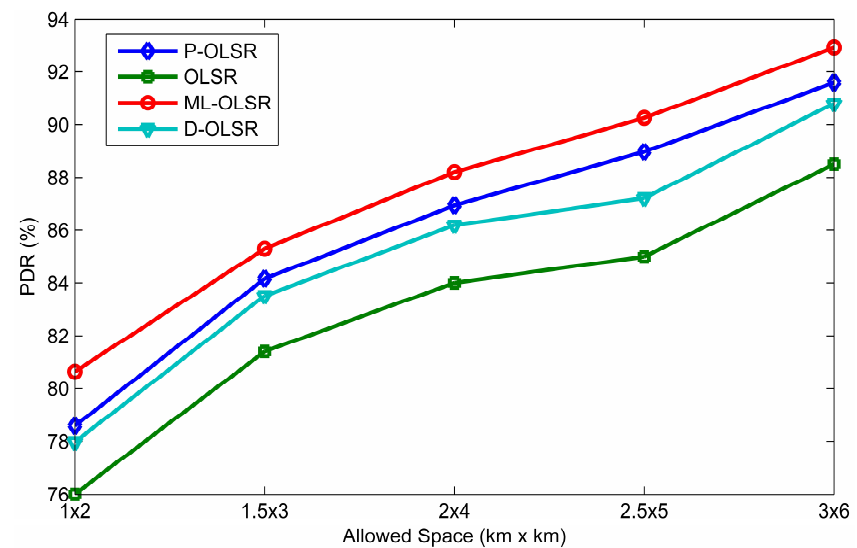
Figure 14. PDR vs. allowed space.